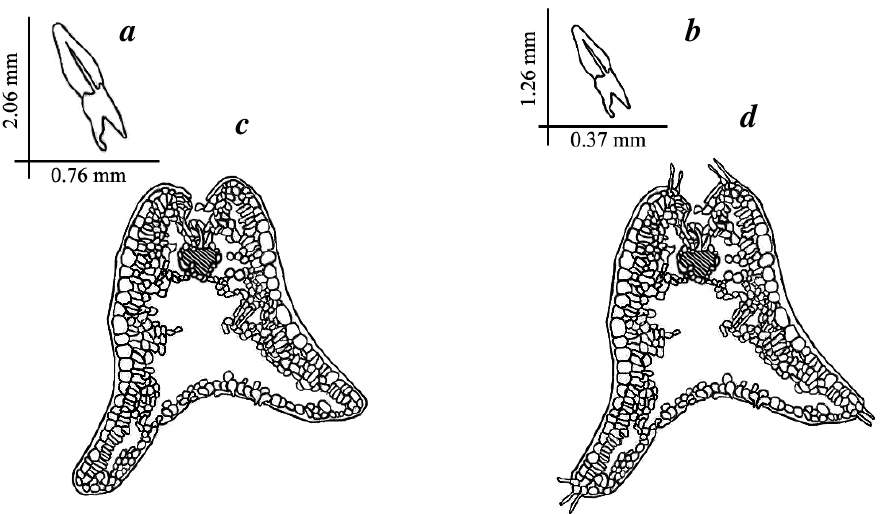
Figure 4. Schematic C. vulgaris leaf morphologic structure and cross-section view: ( a , c )—Pritobolye type; ( b , d )—Baltic type. Table 2. Leaf morphological and anatomical parameters of C. vulgaris in typical Pritobolye (Za- vodouspenskoe) and Baltic (Luga) populations.